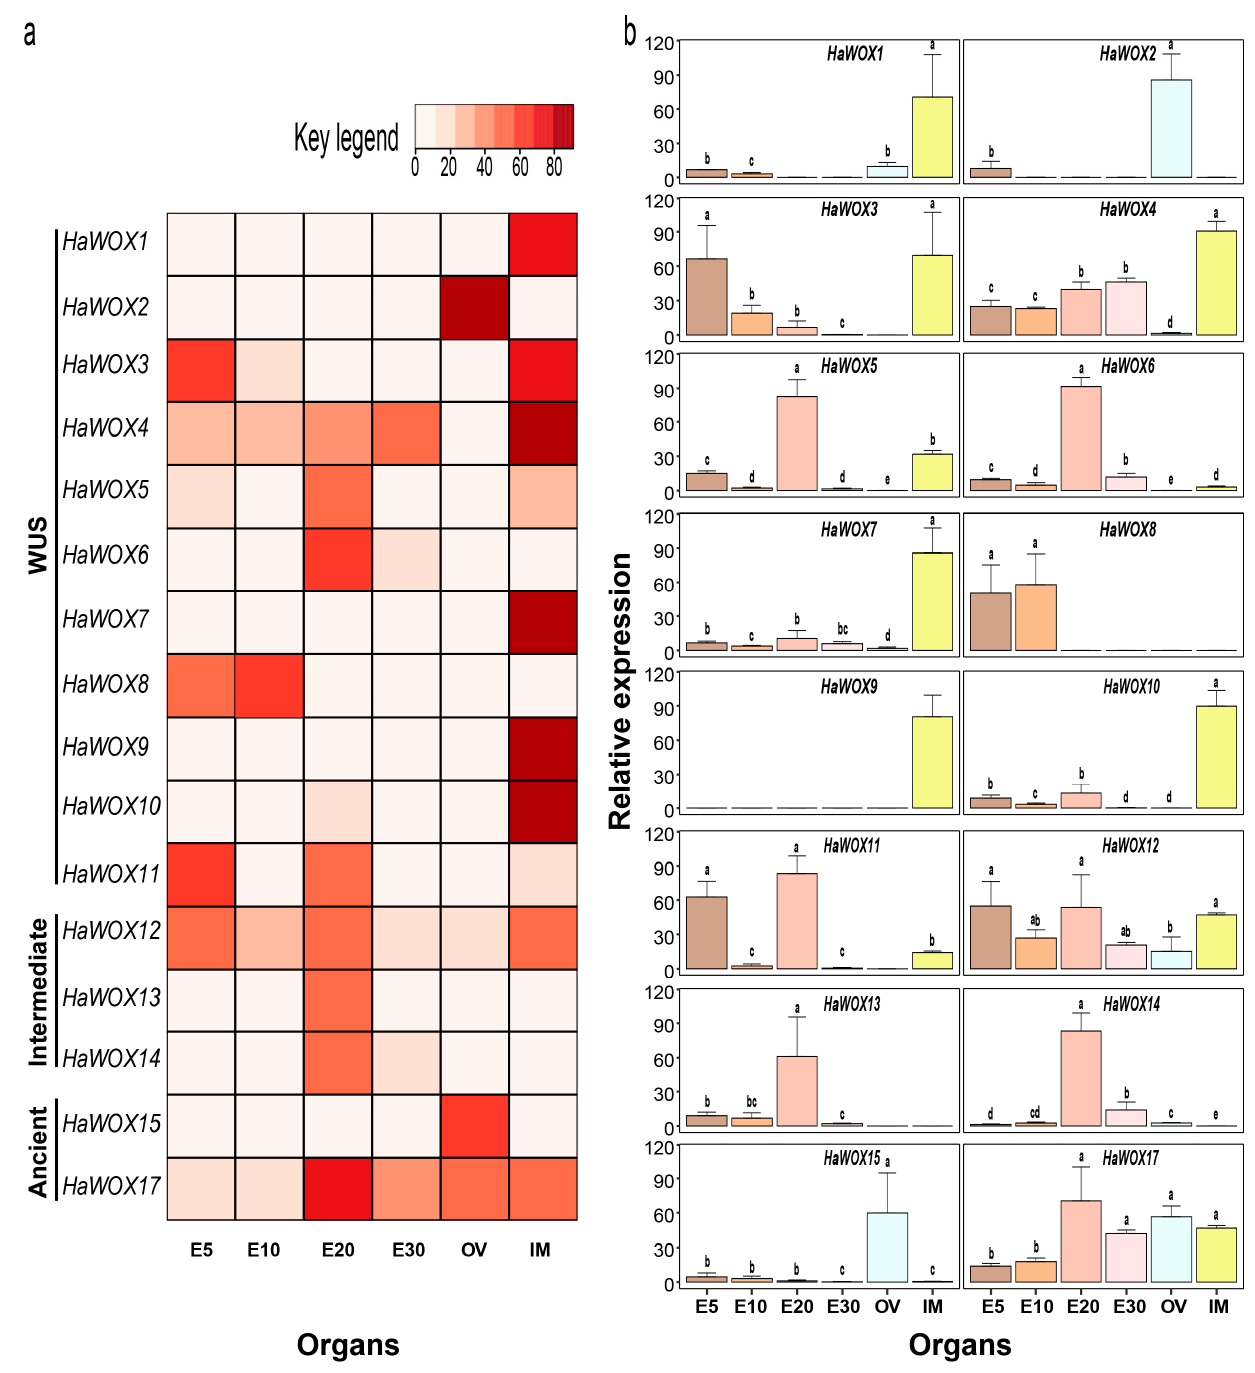
Figure 7. Expression profile of H. annuus WUSCHEL HOMEOBOX-like ( HaWOX ) in the ovule (OV), inflorescence meristem (IM), and at different stages of embryo development (E5, E10, E20, and E30). ( a ) Heatmap graph of HaWOX relative expression, scale range from dark to light red for higher and lower expressed genes, respectively. ( b ) Bar plots of HaWOX relative expression: heights for each gene indicate relative differences in expression level; bars show the average value for three biological replicates. Different letters indicate statistically significant differences between organs after one-way ANOVA according to Tukey’s HSD post hoc test ( p <